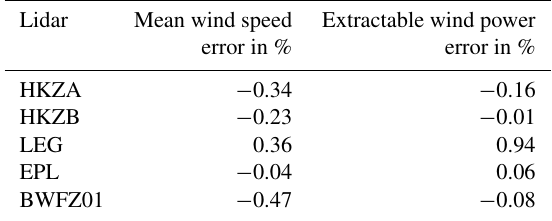
Table 2. Estimation of mean wind speed error and extractable wind power error due to low temporal SAR